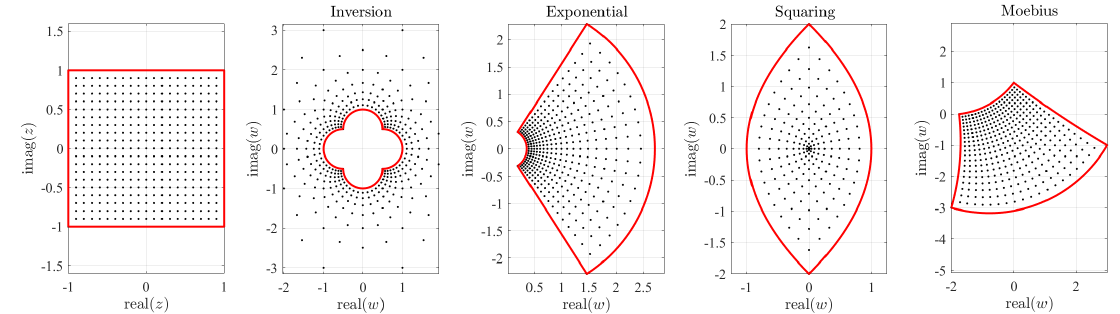
Figure 1. Examples of complex conformal